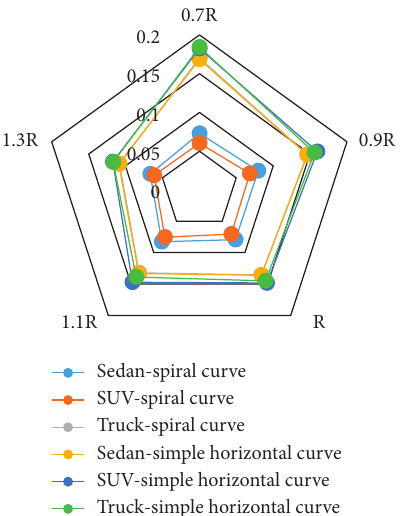
Figure 26: Maximum lateral distance in the simple and spiral horizontal curves for various radii and the speed of 100km/h.